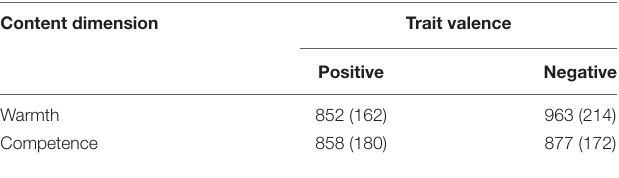
TABLE 3 | Mean (SD) error percentages to the key trait probes as a function of content dimension and